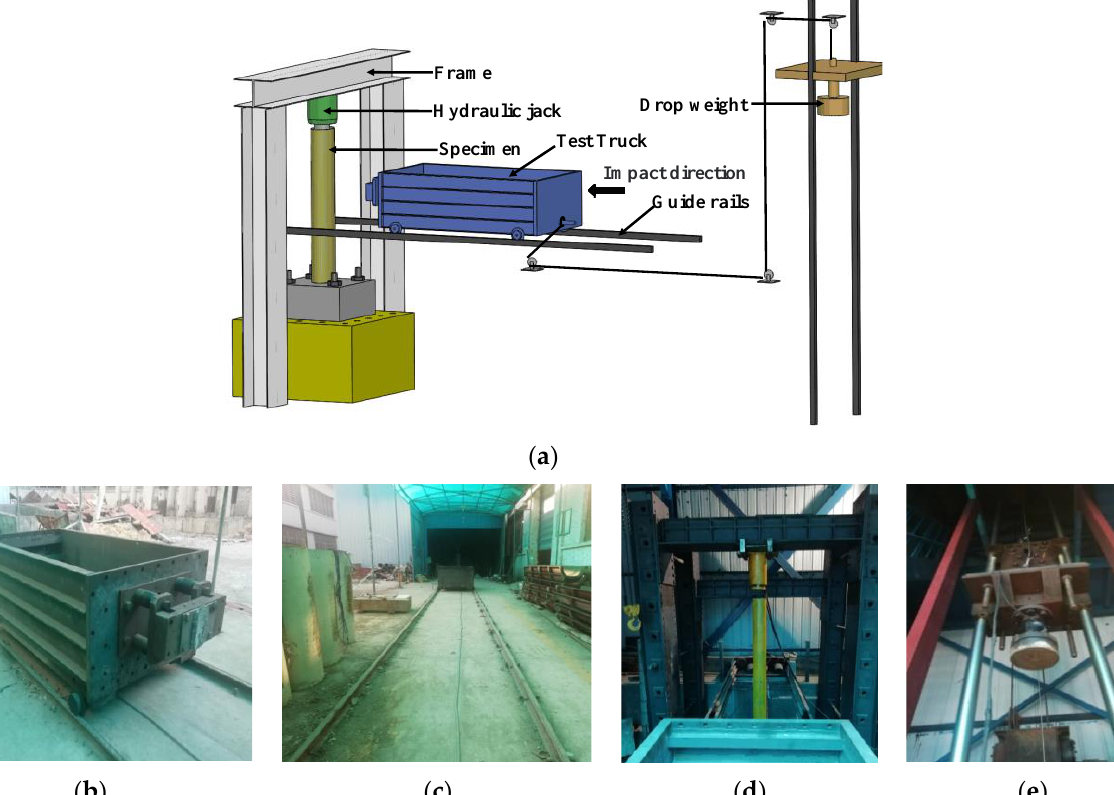
Figure 2. Impact test setup. ( a ) Sketch of the facility; ( b ) The instrumented hammer with test truck; ( c ) Test truck on the rails; ( d ) Specimen inside the frame; ( e ) Drop weight.